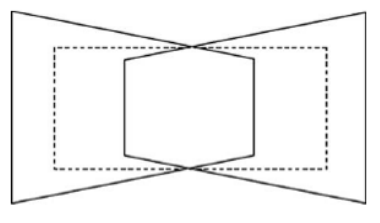
Figure 7. The equivalent image by projected If the elements of the relative positing orientation between two cameras are calculated with no error and the expositing of two cameras is strictly synchronous, the overlap of two images will be totally coincident to each other as shown in Fig.7. However, the overlap of two images will not be totally coincident to each other with the two